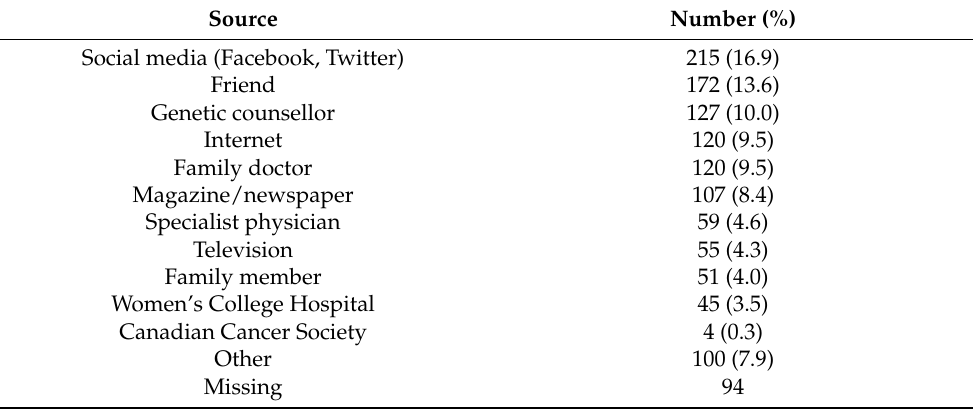
Table 2. Sources of referral to the Screen